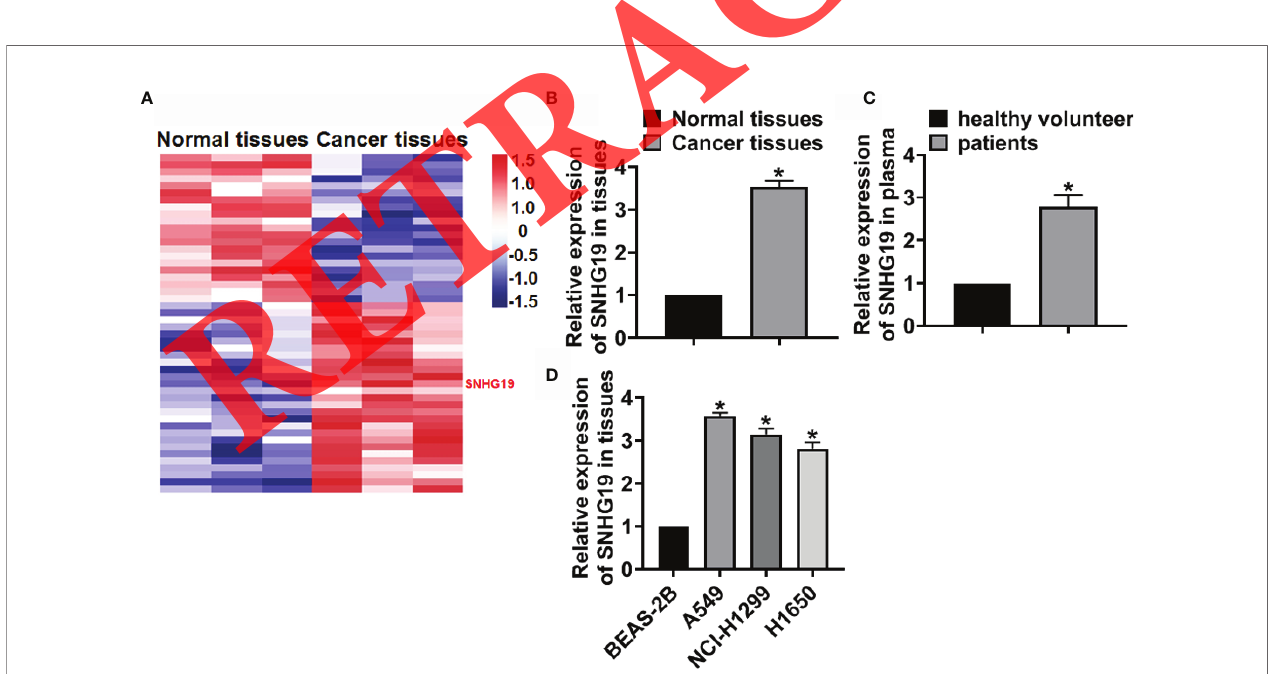
FIGURE 1 | The expression of lncRNA SNHG19 in NSCLC tissues and cells. (A) LncRNA expression pro fi les in adjacent normal tissues and cancer tissues of NCSLC patients. (B) We collected 60 samples of patients diagnosed with NSCLC. The expression of SNHG19 in normal and cancer tissues was detected by qRT- PCR. n = 60. (C) RNA in plasma of healthy volunteers and NSCLC patients was isolated, and SNHG19 expression was calculated. (D) qRT-PCR analysis for SNHG19 level in NSCLC cell lines (A549, NCI-H1299 and H1650) and human normal pulmonary epithelial cells BEAS-2B. Data are mean ± SD; *P < 0.05. All experiments were repeated three